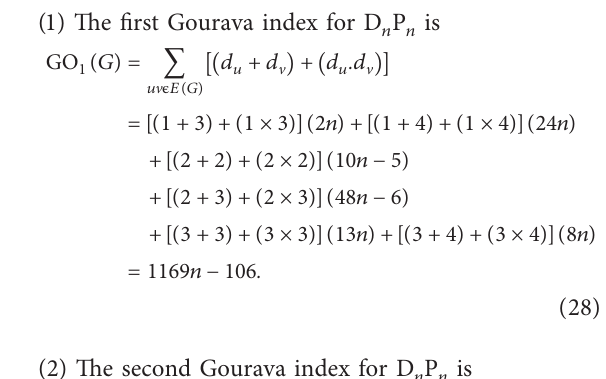
Figure 27: Plots of the second hyper-Gourava index for m − Bil